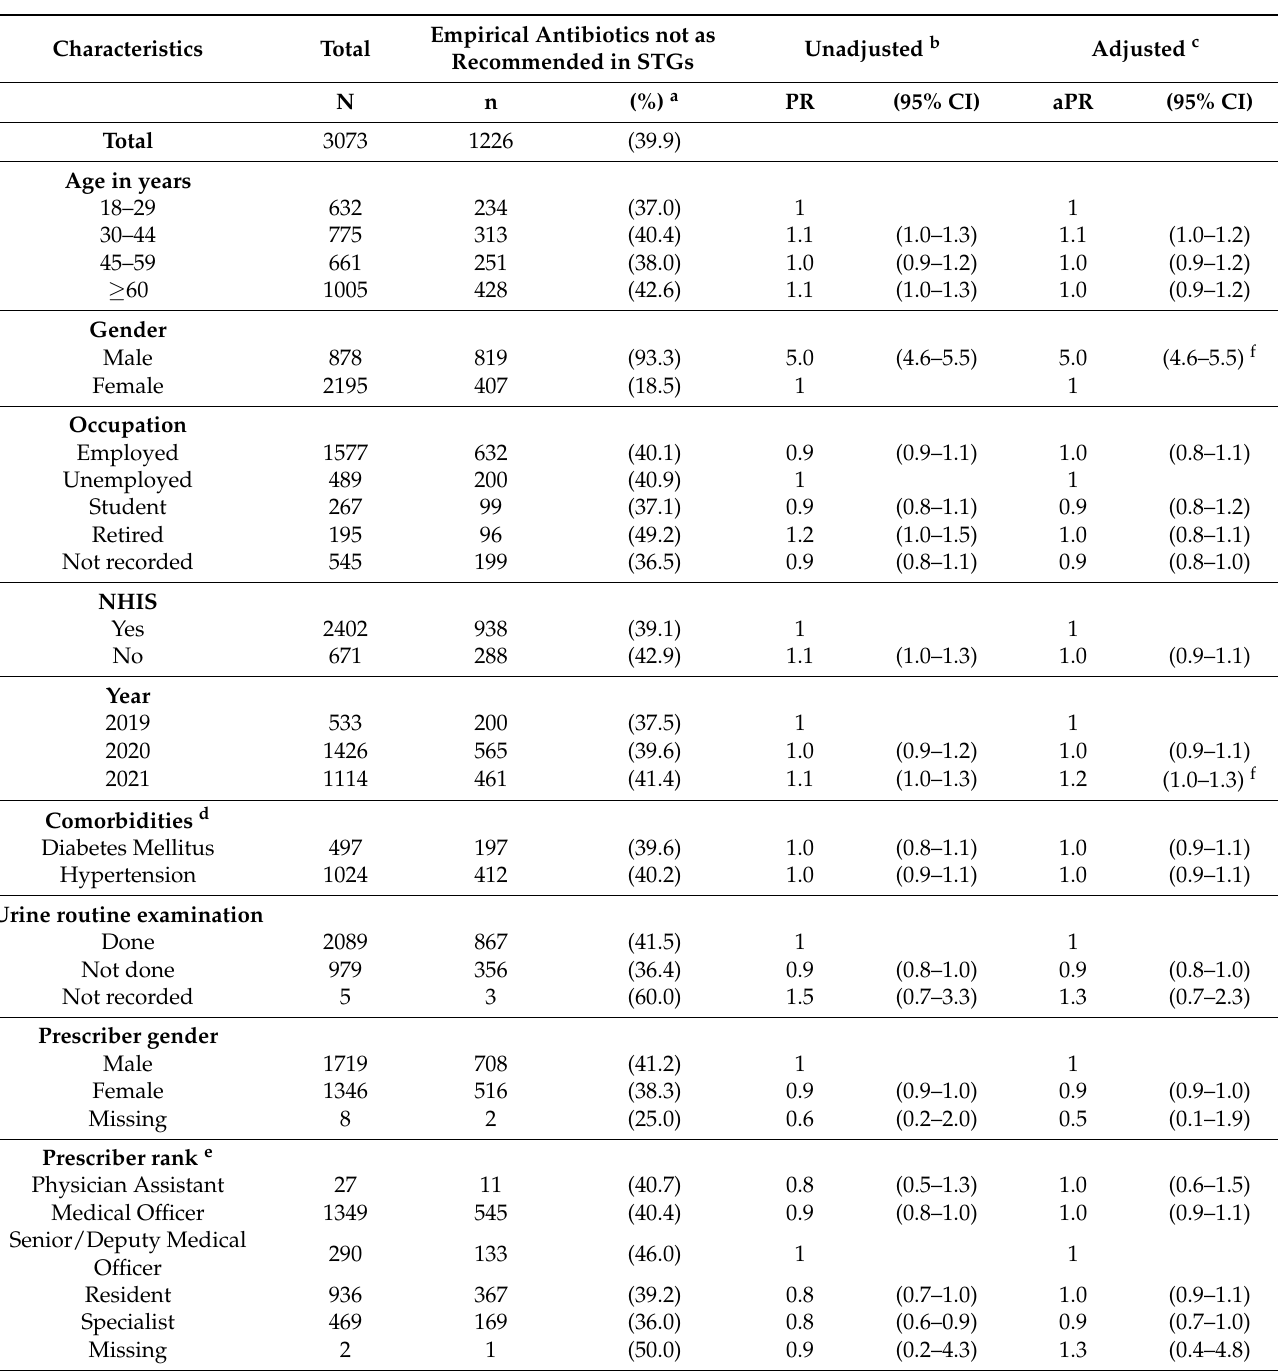
Table 2. Patient and prescriber characteristics associated with prescription of empirical antibiotics not as recommended in the STGs among adults prescribed any empirical antibiotic for